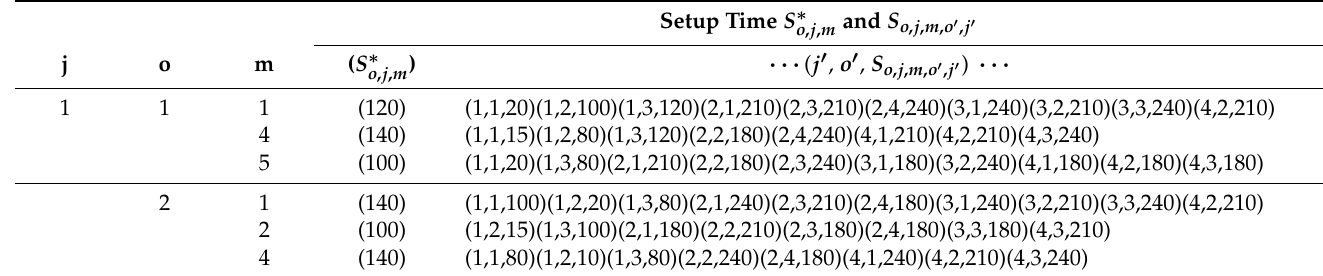
Table 2. Sequence-dependent setup time data for